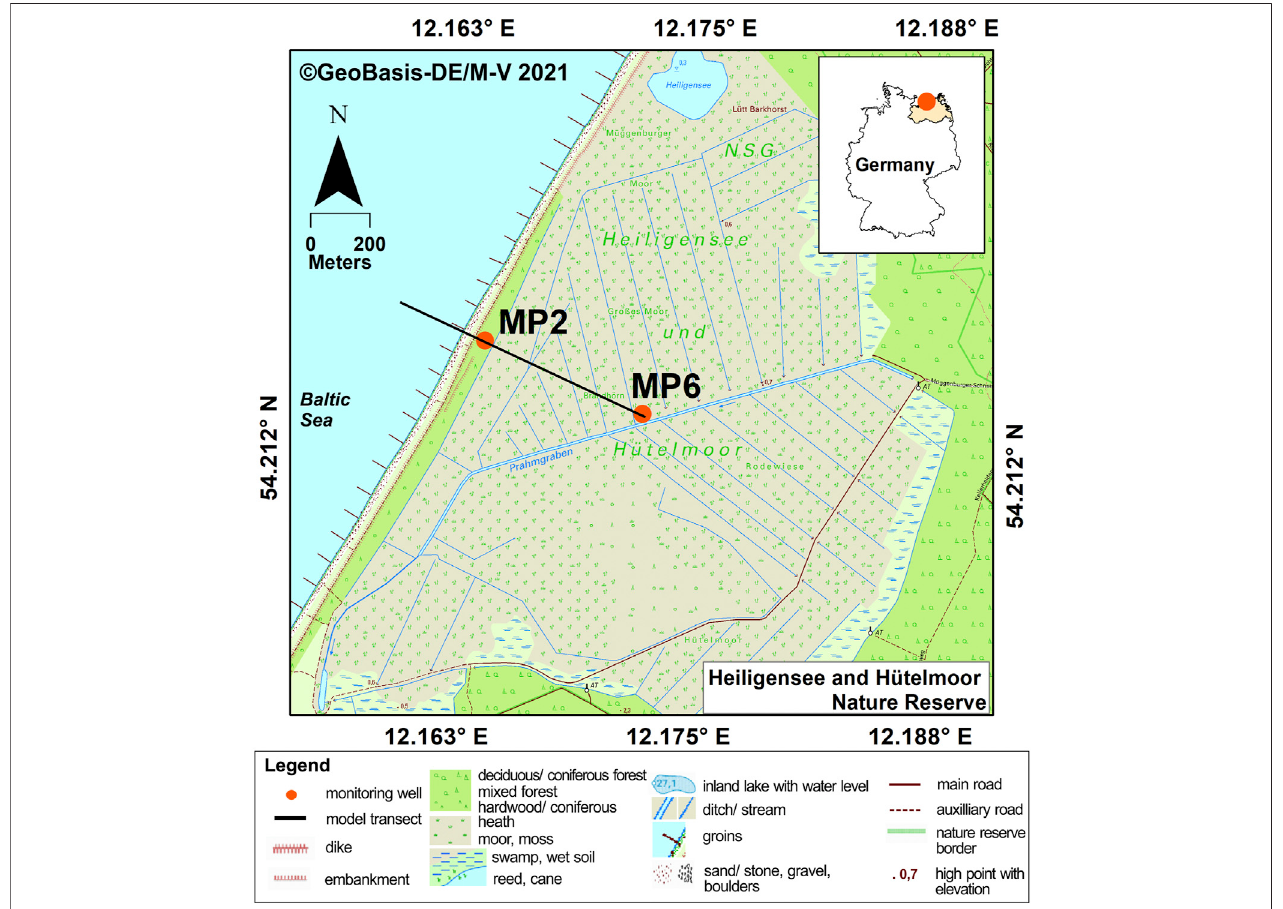
FIGURE 1 | The nature reserve “ Heiligensee und Hütelmoor, ” in Mecklenburg-Western Pomerania, Germany. The black line indicates the transect for the 2D groundwater model. MP2 and MP6 are groundwater observation wells. A groundsill was installed at the outlet of the ditch system in December 2009, restricting the drainage function of the ditches to high water levels. The background topographical map was taken from https://www.laiv-mv.de/Geoinformation/Karten/ Topographische-Karten/.